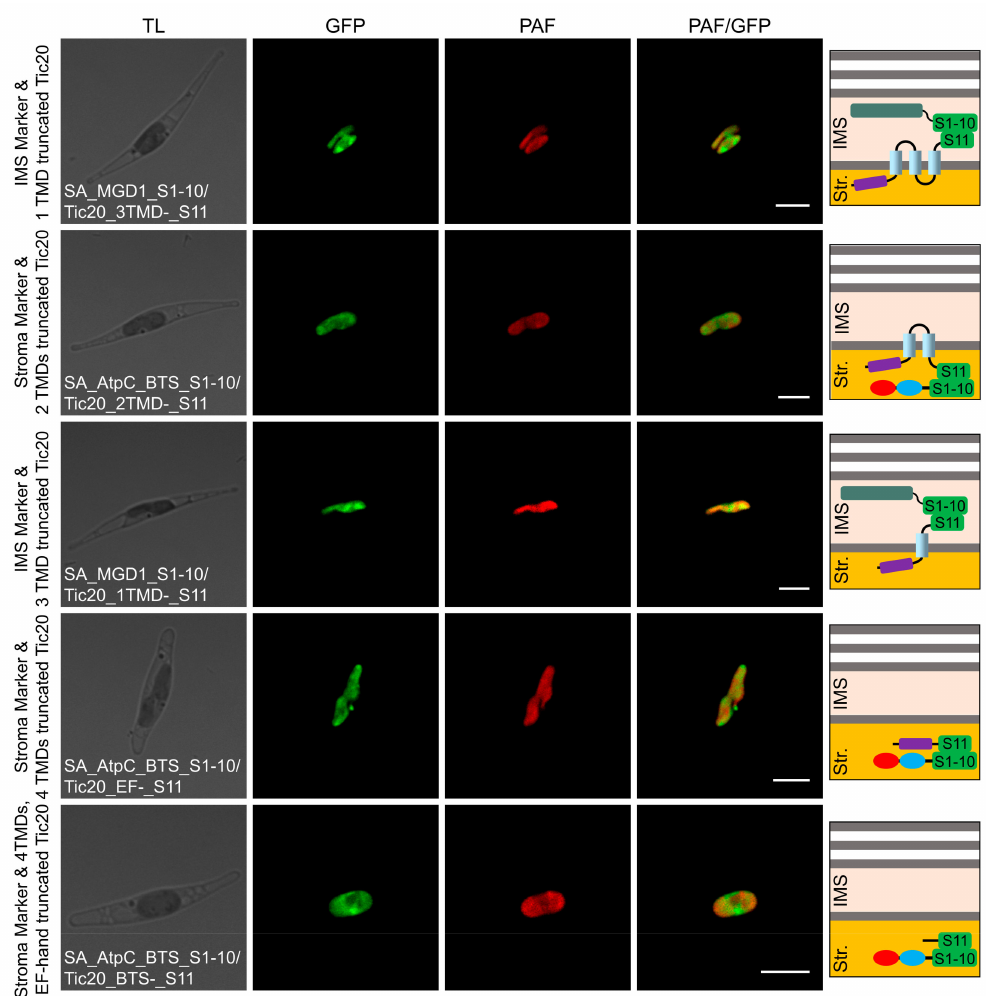
Figure 6. Self-assembling GFP assay analyzing the localization of domain-truncated versions of SjTic20-14 in P. tricornutum . SA_MGD1_S1-10 / Tic20_3TMDs-_S11: co-expression of